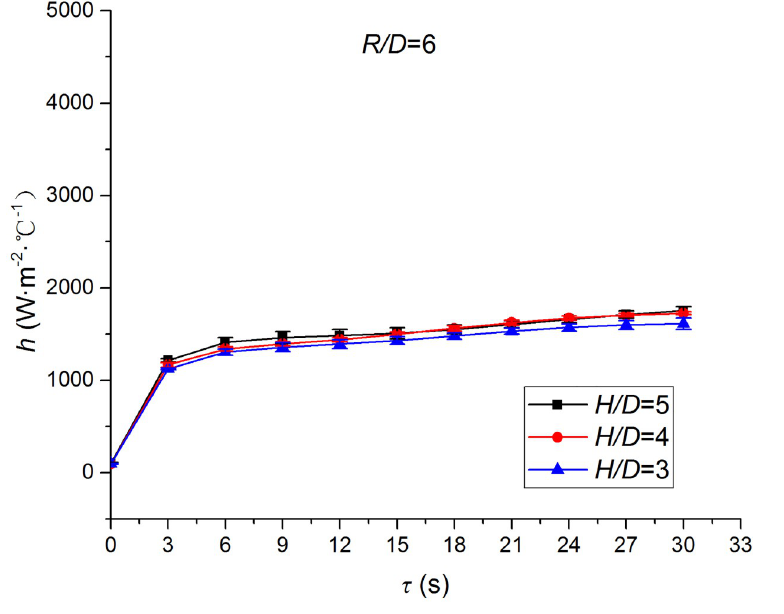
Fig 32. Convective heat transfer coefficient at R/D = 6.